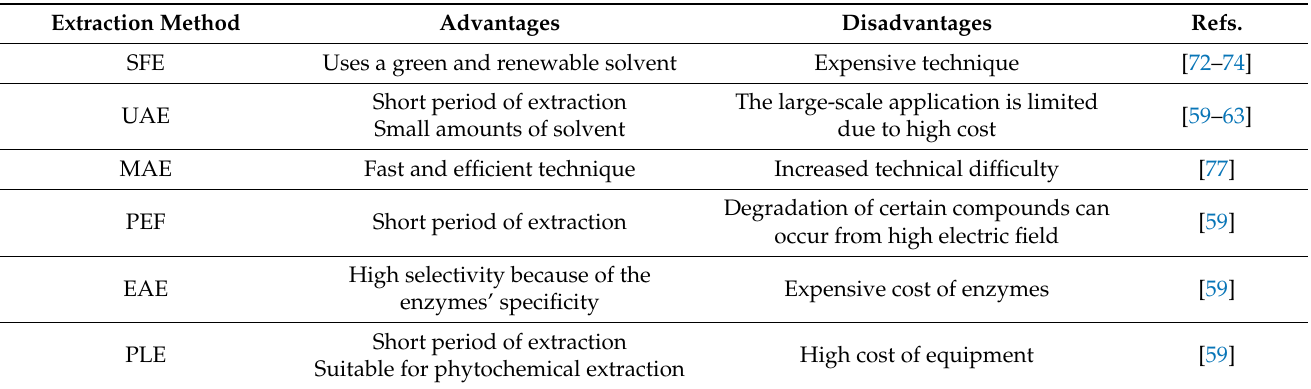
Table 2. Comparison of advantages and disadvantages of novel extraction method. Extraction